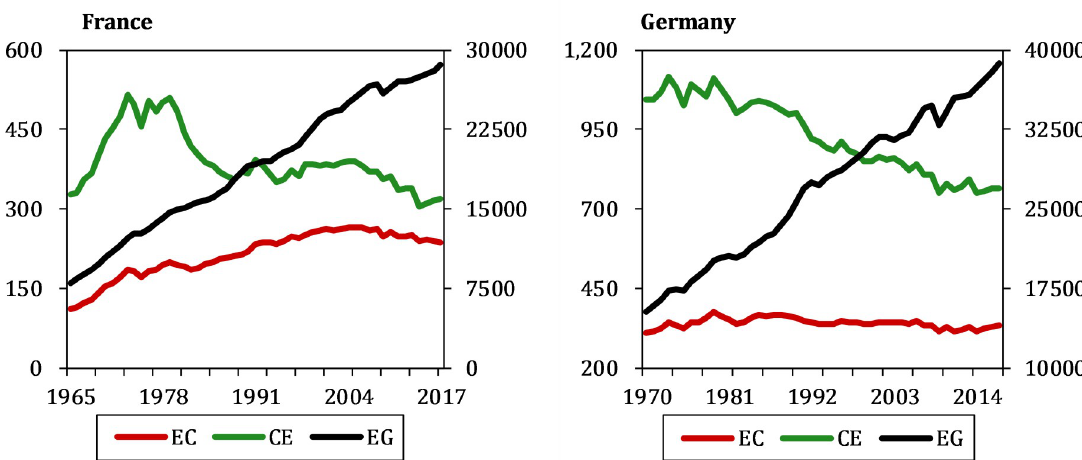
Fig 2. The temporal trends of EC, CE and EG for France and